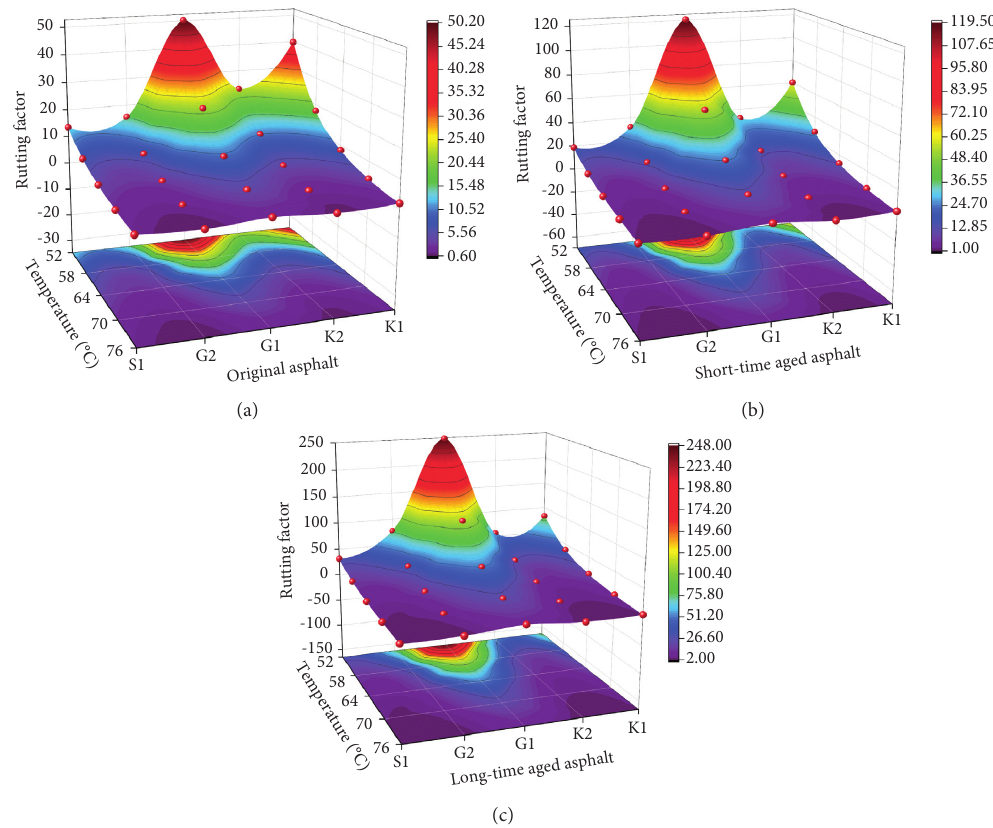
Figure 4: Rutting factor at different aging states. (a) Original asphalt. (b) Short-time aged asphalt. (c) Long-time aged